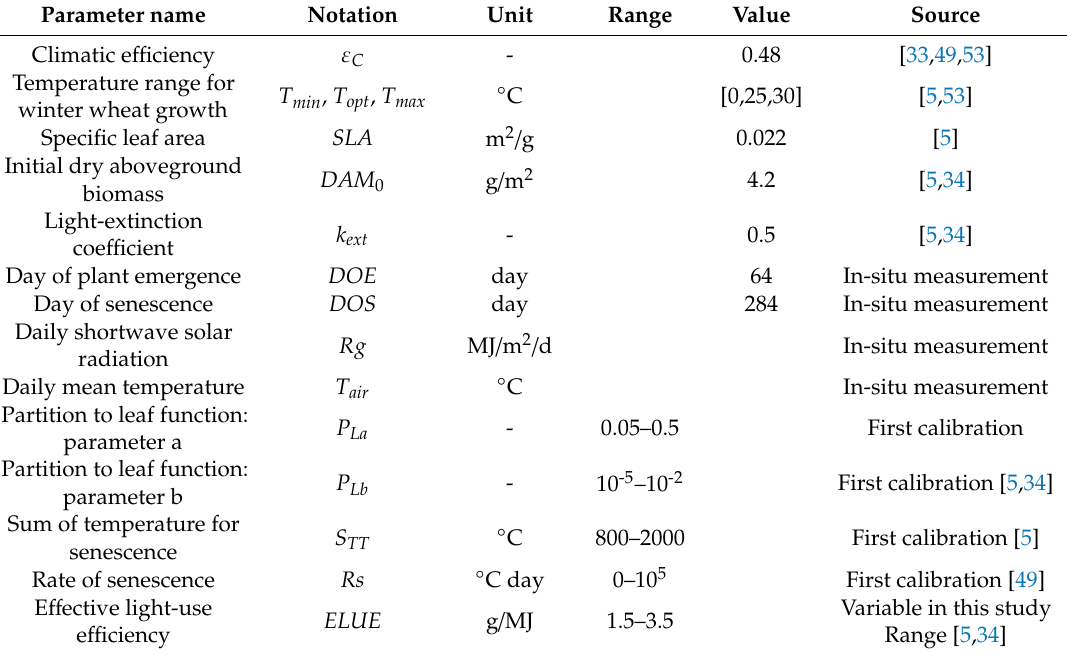
Table 2. SAFY parameters and associated values used in this